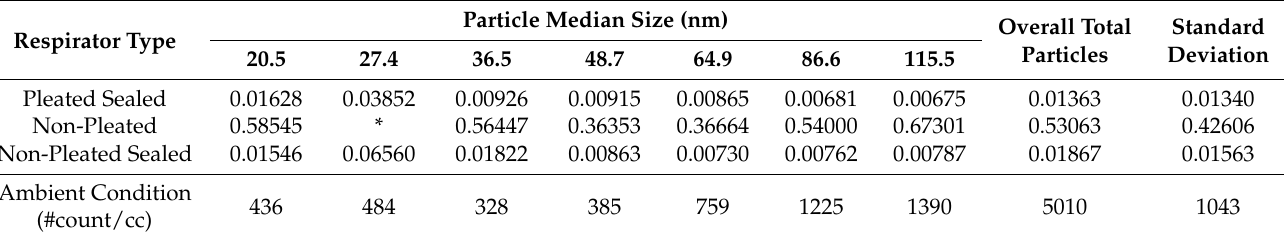
Table 5. Results of average downstream to upstream filtration ratios per type, particle size, and per respirator type at the Asphalt Plant.